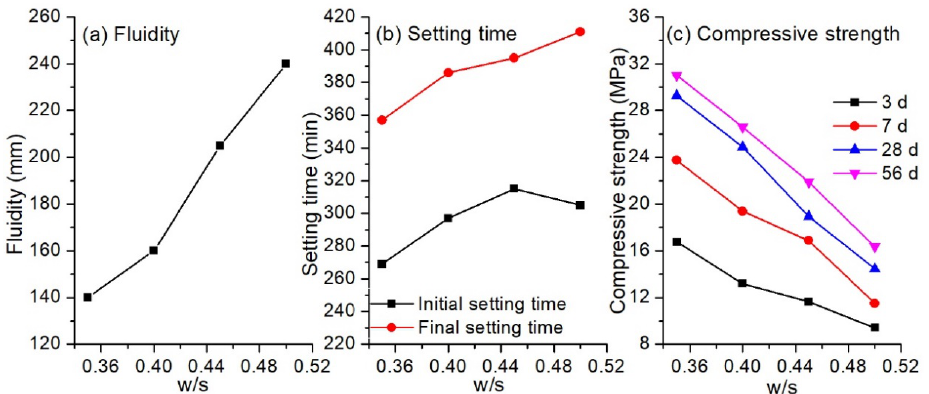
Figure 5. Setting and hardening properties of alkali-activated LFA-GGBS hybrid binder with different water / solid ratios (GGBS content = 25%, Na 2 O content = 10%, n = 1.6): ( a ) fluidity of the binder; ( b ) Setting time of the binder; ( c ) compressive strength of the binder curing for different ages.